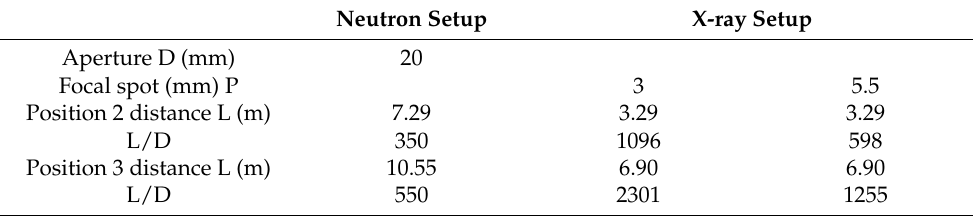
Figure 3. Pneumatic scintillator exchange setup at position 2. Table 2. Beam formation conditions for the neutron and X-ray